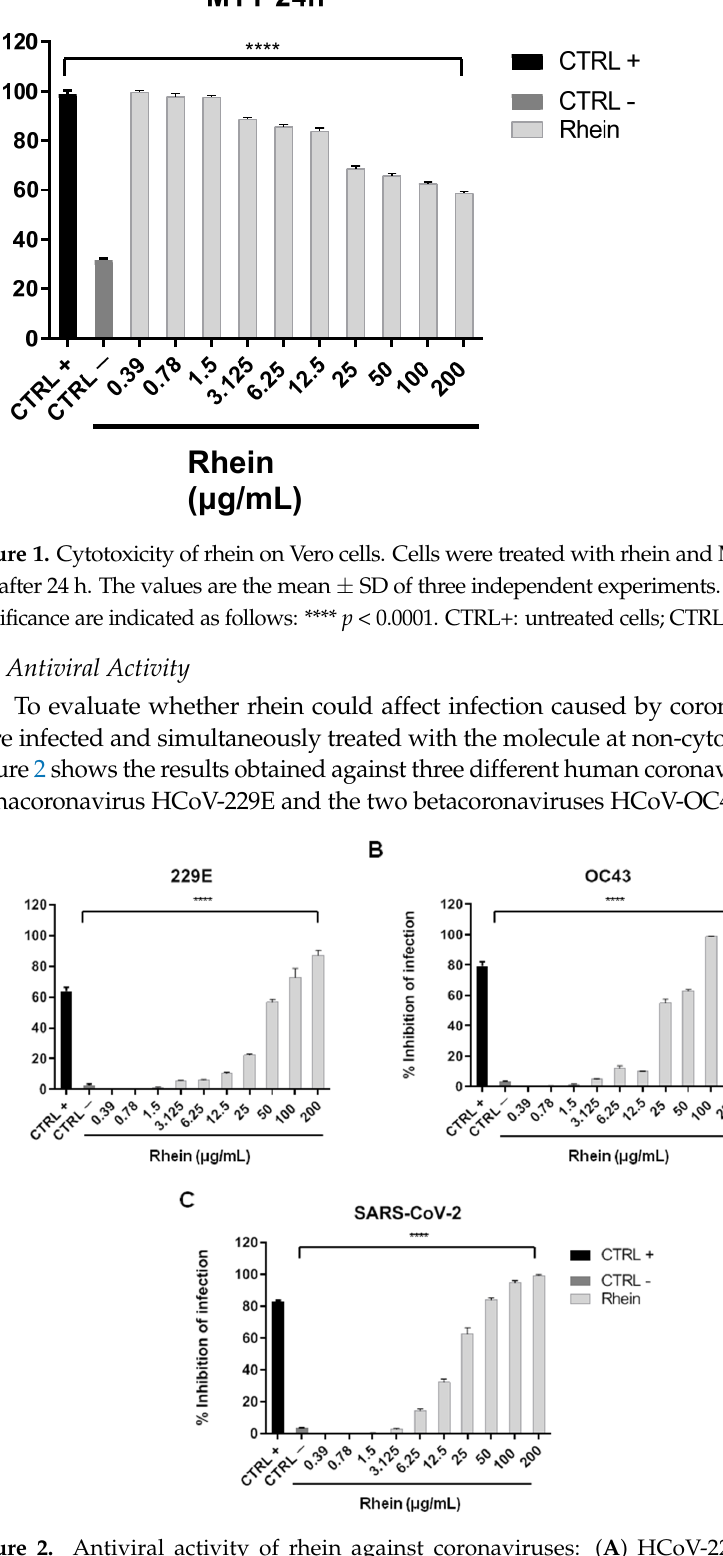
Figure 2. Antiviral activity of rhein against coronaviruses: ( A ) HCoV-229E; ( B ) HCoV-OC43; ( C ) SARS-CoV-2. Cells were exposed to virus and drug at the same time, and viral plaques were revealed after 48 hpi. The values are the mean ± SD of three independent experiments. The levels of statistical significance are indicated as follows: **** p < 0.0001. CTRL+: infected cells treated with 2 μ g/mL ivermectin; CTRL − : infected cells.